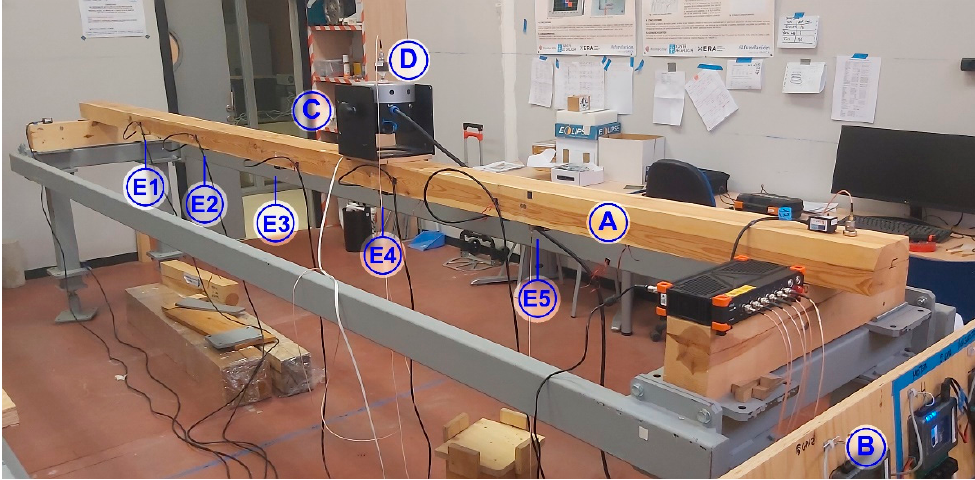
Figure 7. Measurement layout.